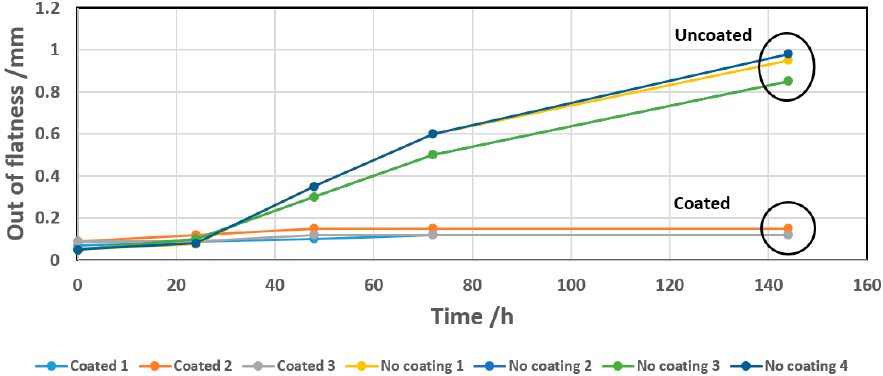
Figure 11. Evolution as a function of time of the deformation (out of flatness) of subassemblies, including coated and uncoated PM adapters, exposed to a temperature-humidity cycle (50 °C, 100% RH up to 144 h) .